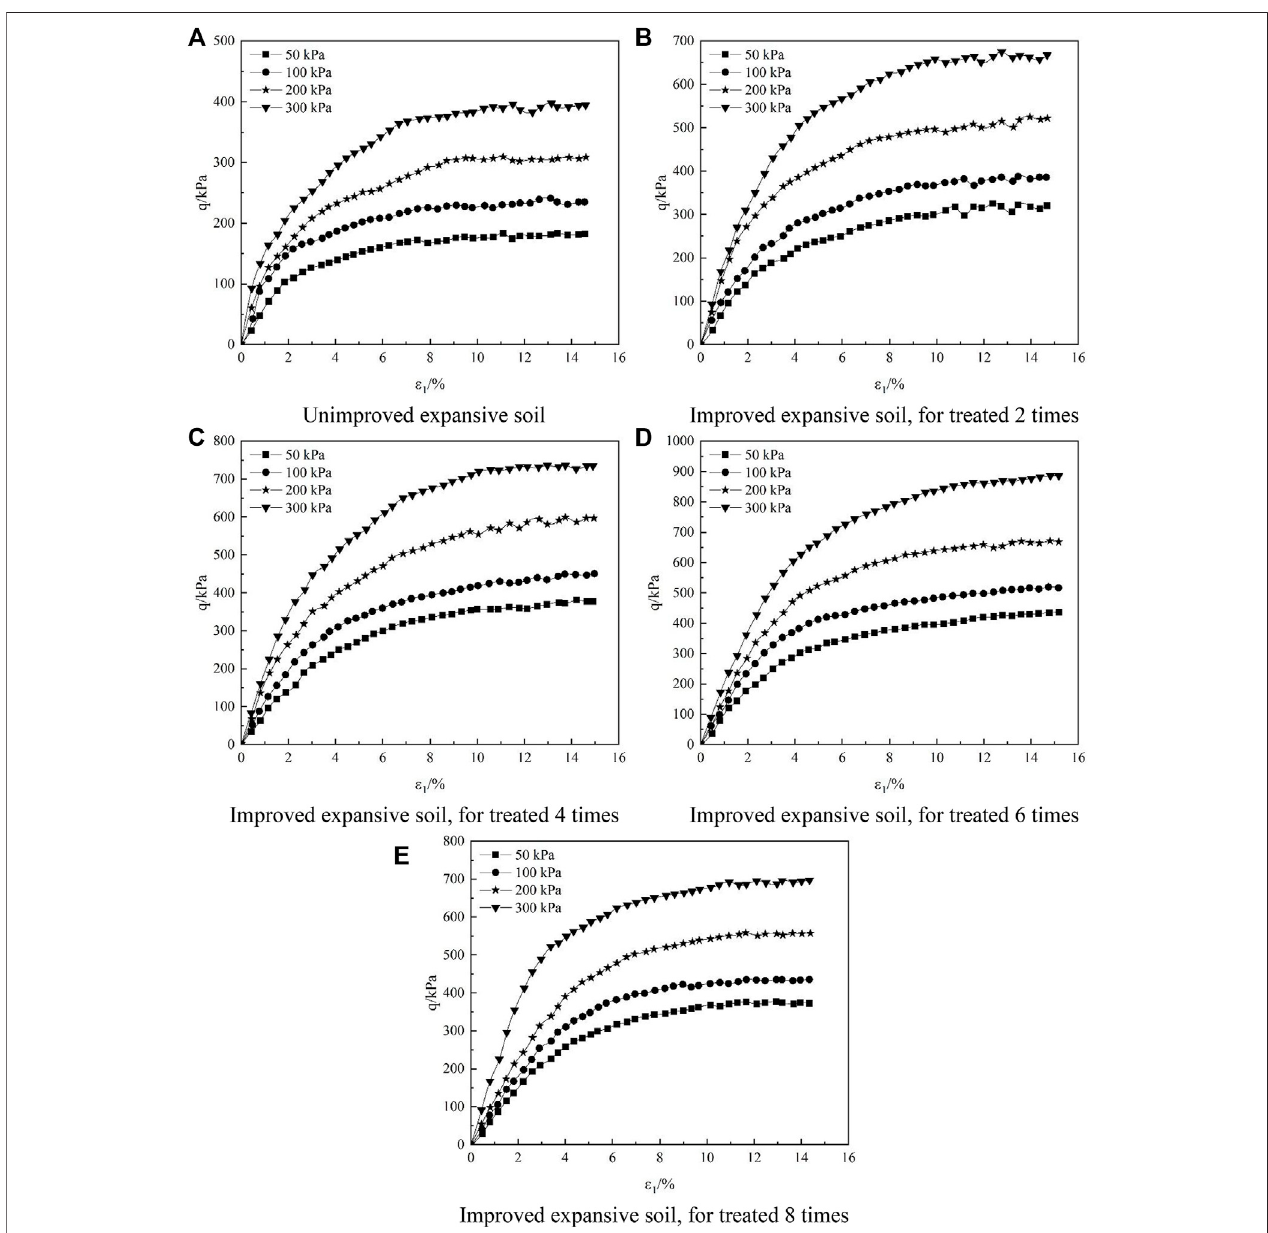
FIGURE 3 | Relations between deviatoric stress and axial